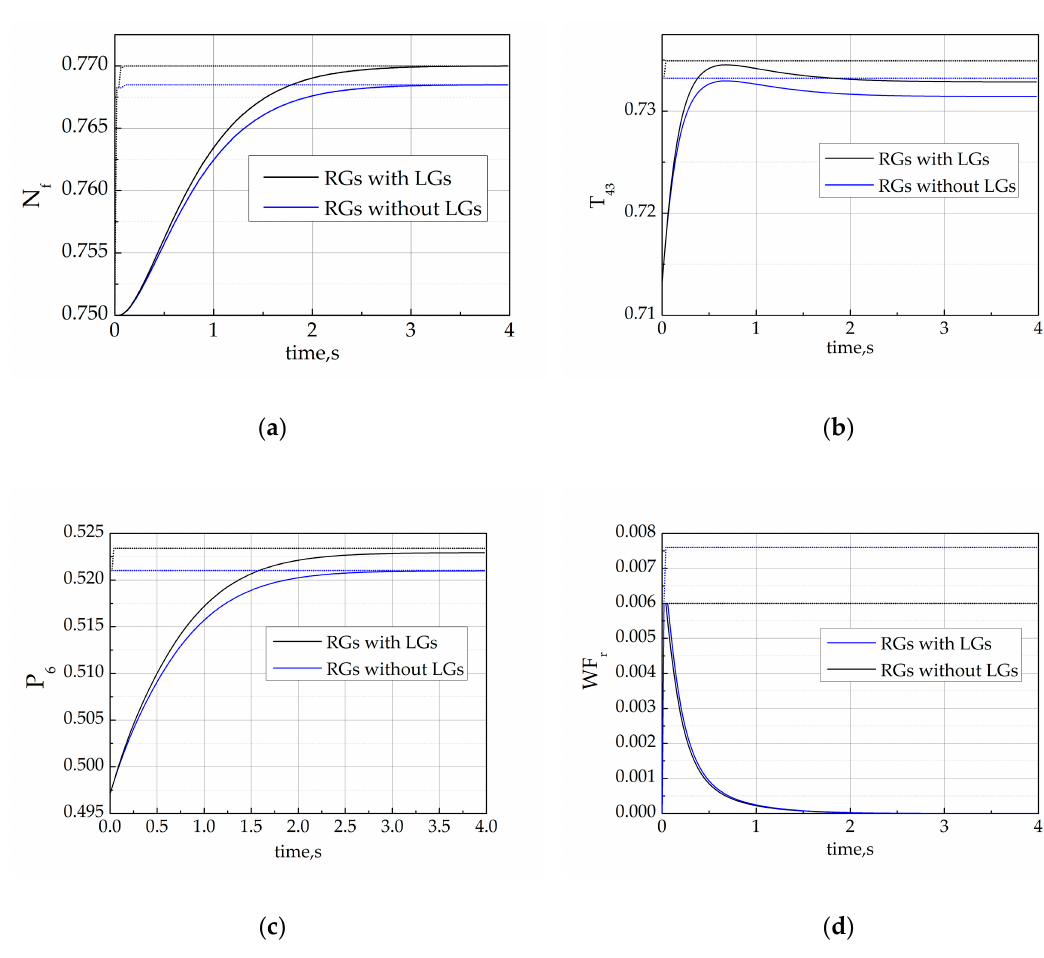
Figure 6. Comparison between RGs with LGs and RGs without LGs. ( a ) The time history of fan speed (solid line) and admissible reference command (dot); ( b ) the time history of the high-pressure turbine outlet temperature (solid line) and corresponding limit (dot); ( c ) the time history of the low-pressure compressor (solid line) outlet pressure and corresponding limit (dot) and ( d ) the time history of the rate of fuel flow (solid line) and corresponding limit (dot).